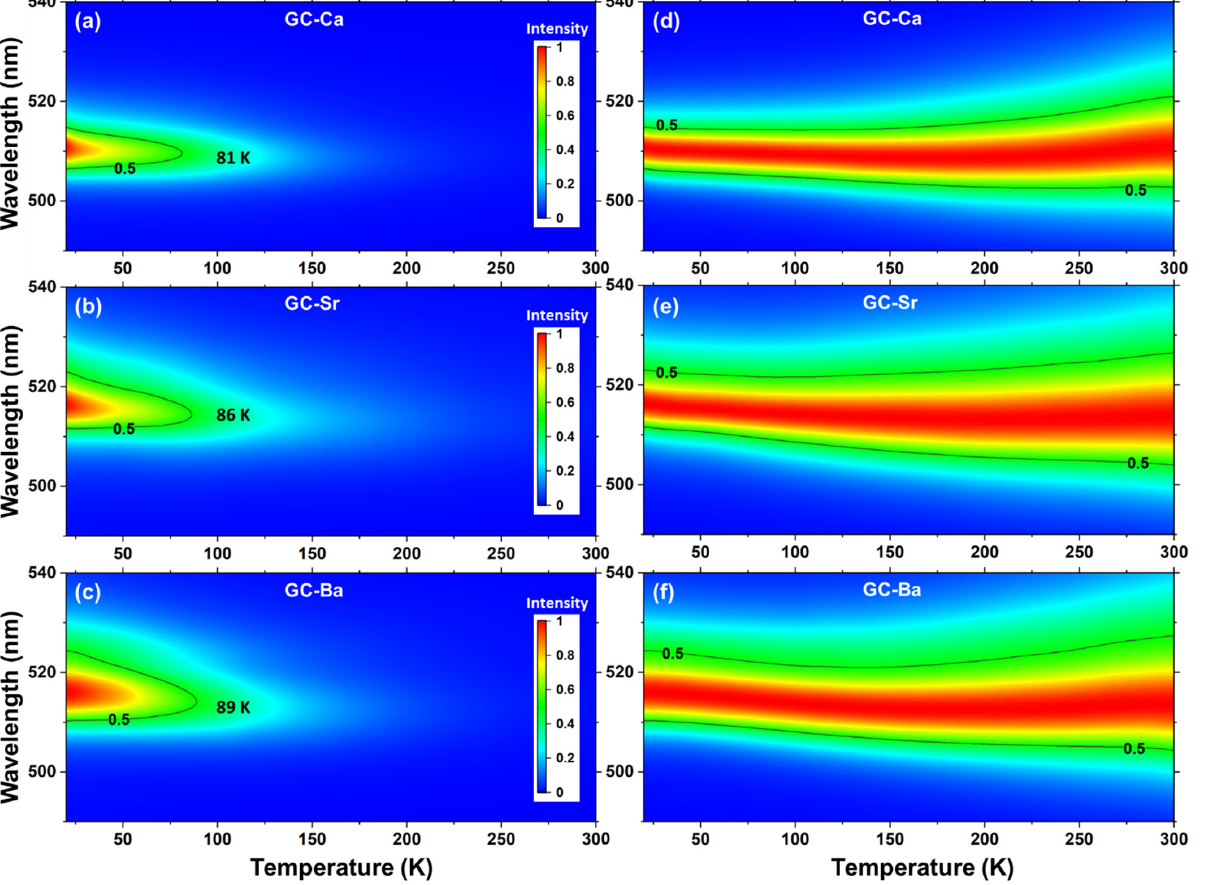
Figure 2. The PL intensity 2D mapping of ( a ) GC ‐ Ca, ( b ) GC ‐ Sr, and ( c ) GC ‐ Ba with wavelength versus temperature. The normalized PL intensity 2D mapping of ( d ) GC ‐ Ca, ( e ) GC ‐ Sr, and ( f ) GC ‐ Ba with wavelength versus temperature, setting the PL intensity of peak at different temperatures as the maximum value.